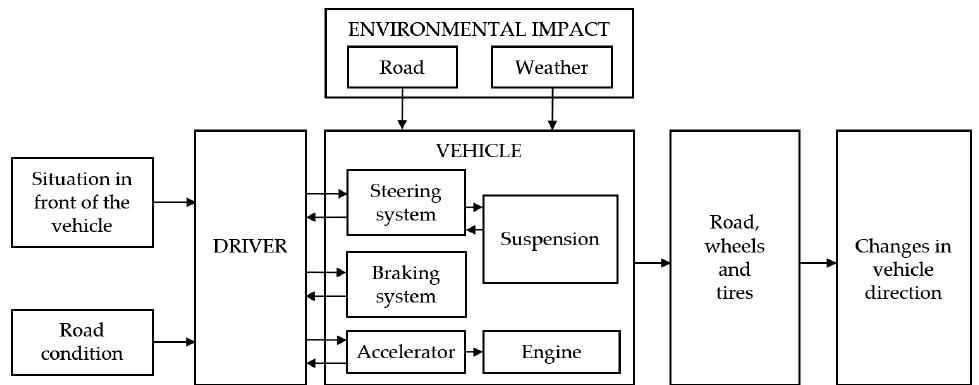
Figure 1. Influence of external factors on vehicle directional stability.